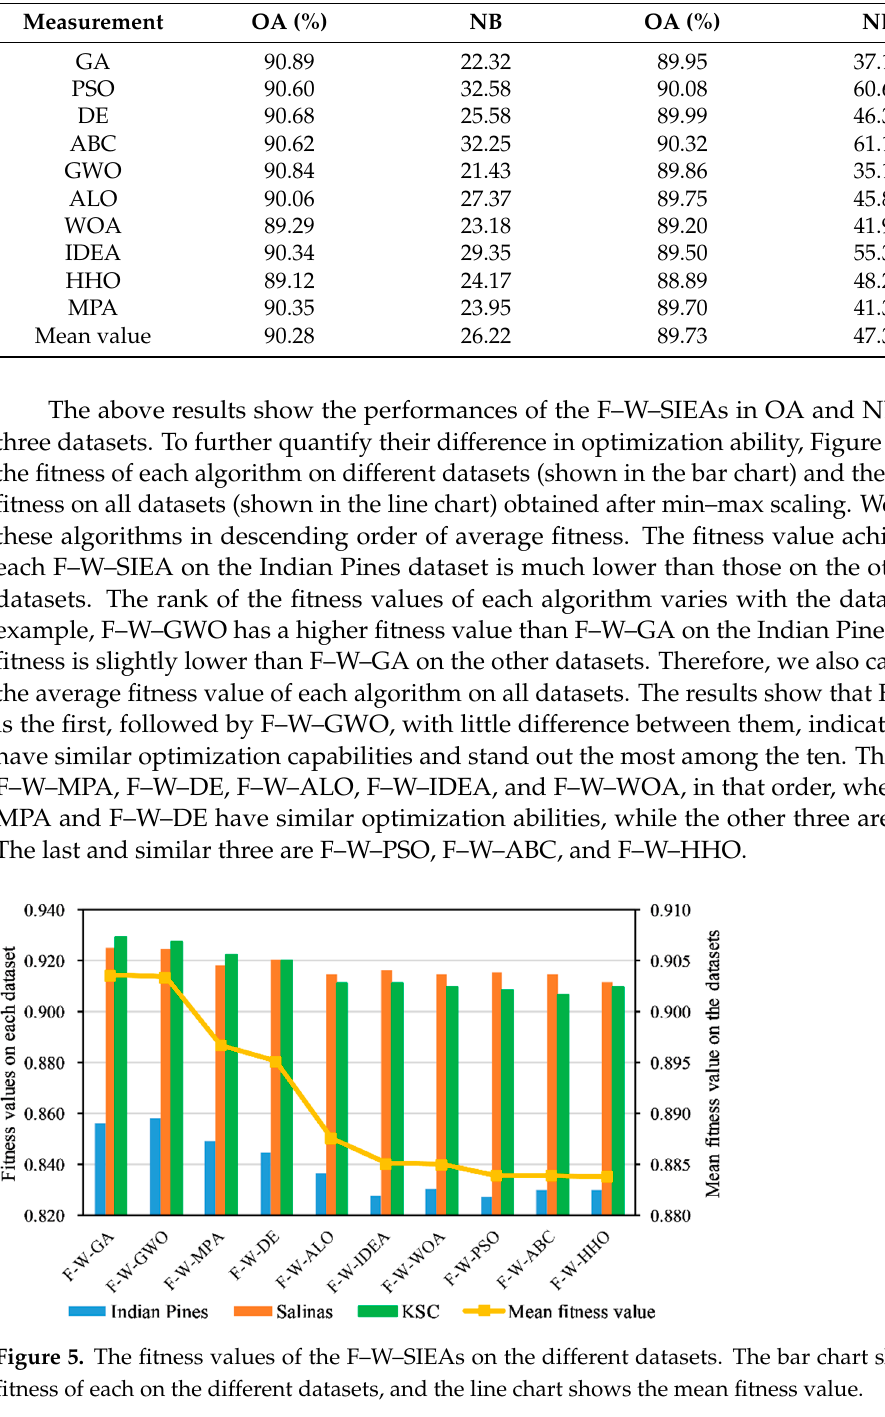
Figure 6. The relative runtime and number of iterations of different algorithms on ( a ) the Indian Pines dataset, ( b ) the Salinas dataset, and ( c ) the KSC dataset. In terms of the relative runtime, each F–W–SIEA runs faster than the corresponding pure SIEA. The result demonstrates that the computing efficiency of each SIEA is